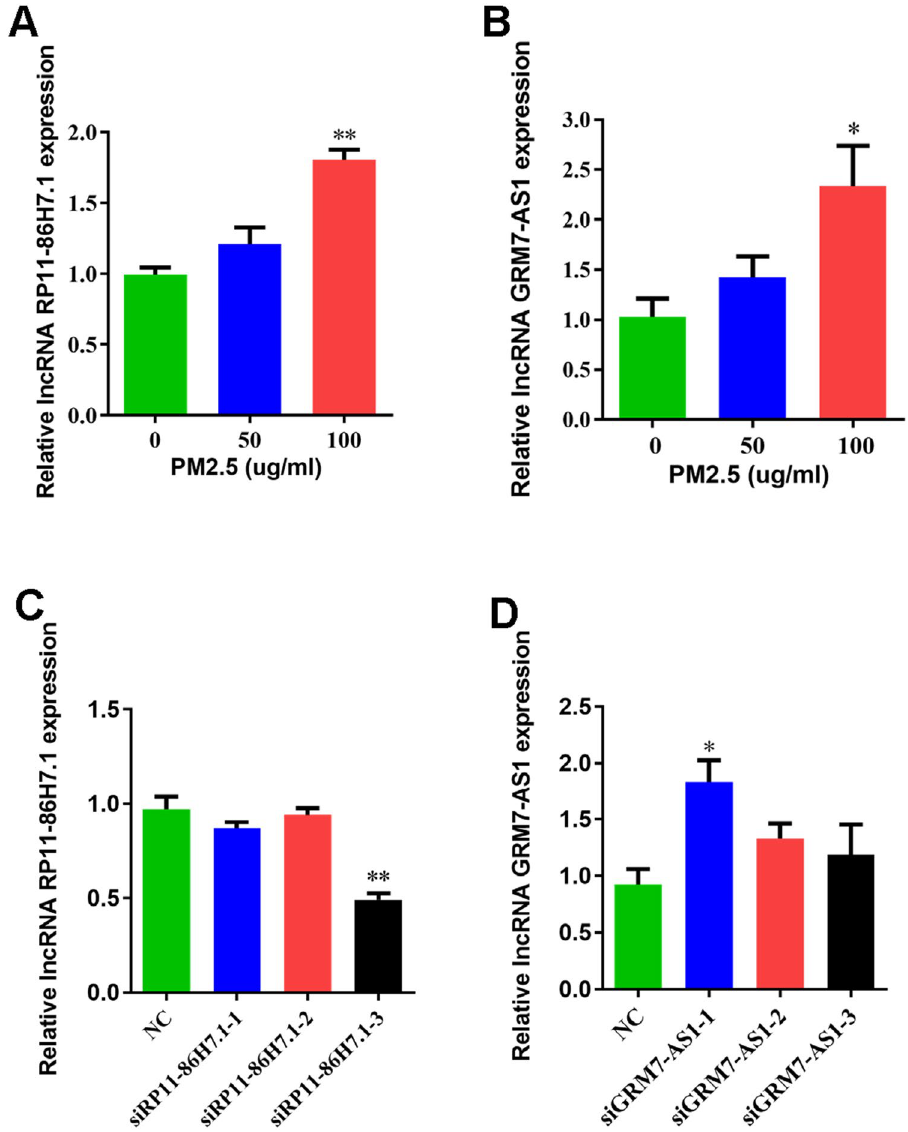
Figure 2. Screening and validation of lncRNAs related to the NF-κB signaling pathway. ( A ) Q-PCR analysis of lncRNA RP11-86H7.1 expression level in HBECs after TRAPM2.5 treatment. ( B ) Q-PCR analysis of lncRNA GRM7-AS1 expression level in TRAPM2.5-treated HBECs. ( C ) Q-PCR analysis of the three target sequences by RNA interference of the lncRNA RP11-86H7.1. ( D ) Q-PCR analysis of the three target sequences by RNA interference of the lncRNA GRM7-AS1. The data are shown as the means ± standard deviations (n = 3). The statistical significance of the data was assessed by Student’s t test. * P < 0.05, ** P < 0.01. siRNA RP11-86H7.1-1: interference fragment 1 of lncRNA RP11-86H7.1; siRNA RP11-86H7.1-2: interference fragment 2 of lncRNA RP11-86H7.1; siRNA RP11-86H7.1-3: interference fragment 3 of lncRNA RP11-86H7.1; siRNA GRM7-AS1-1: interference fragment 1 of lncRNA GRM7-AS1; siRNA GRM7-AS1-2: interference fragment 2 of lncRNA GRM7-AS1; siRNA GRM7-AS1-3: interference fragment 3 of